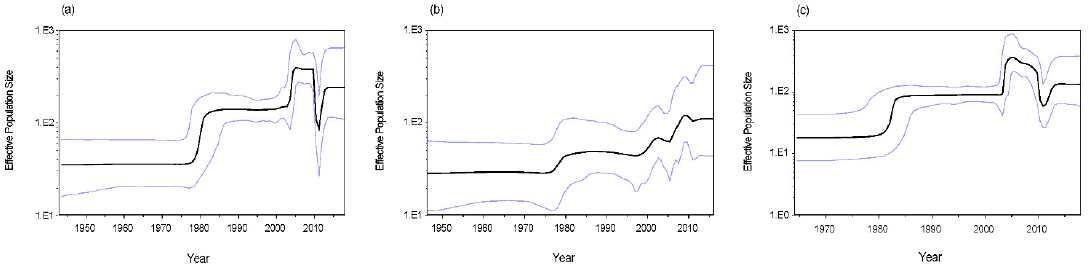
Figure 7. Bayesian skyline plots of RVA G1 VP7 gene: ( a ) all analyzed strains, ( b ) lineage I, ( c ) lineage II. The Y ‐ axis indicates the effective population size. Mean effective population is shown as a black line. The 95% highest posterior densities are shown as light blue lines.